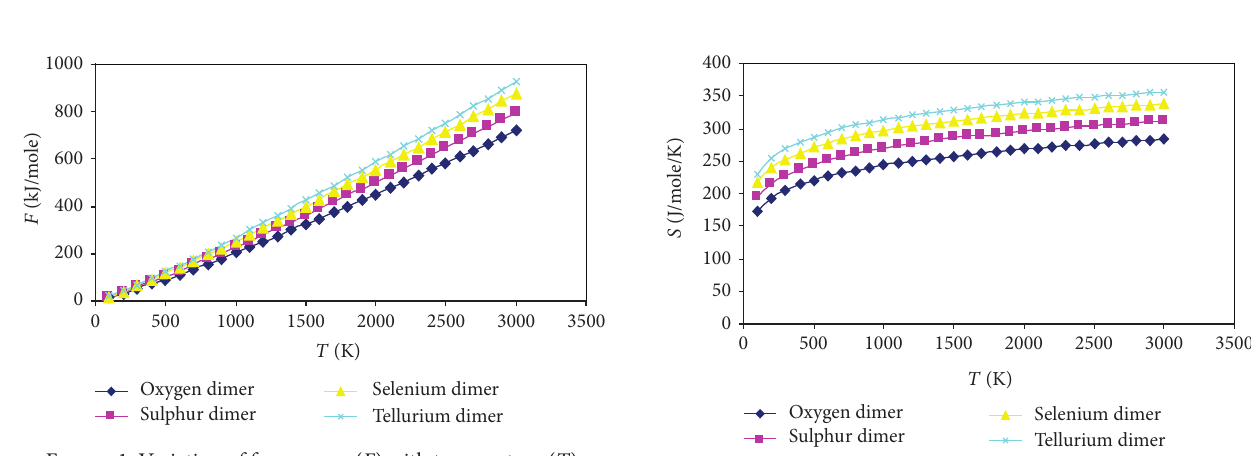
F 1: Variation of free energy ( F ) with temperature ( T ).